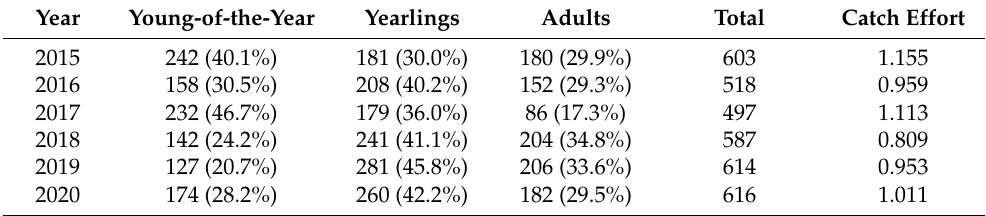
Table 1. Age-at-harvest numbers (and percentages) and estimated catch effort (in terms of total trap-nights, scaled to a mean of one) for North American river otter in Indiana, USA,